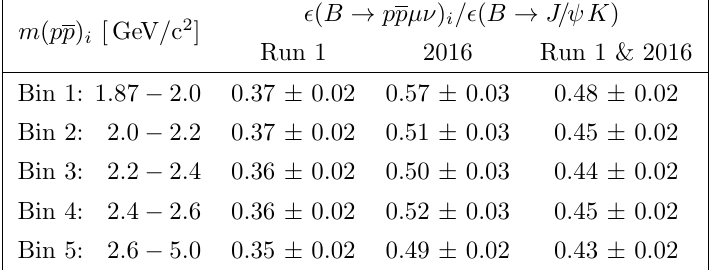
Table 1 . Relative e(cid:14)ciencies for Run 1 and 2016 and the weighted combination of